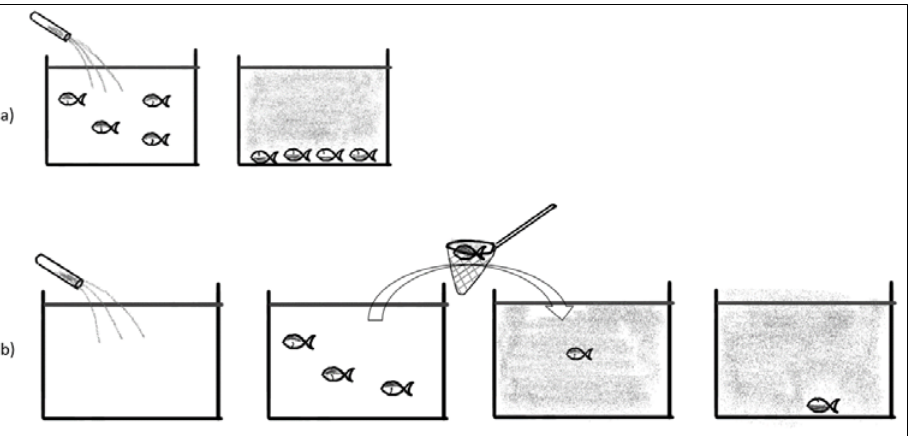
Figure 1. ( a ) Showing anesthesia solution directly into home tank. All fish will be anesthetized. ( b ) Individual fish are restrained and moved directly to the anesthesia bath.